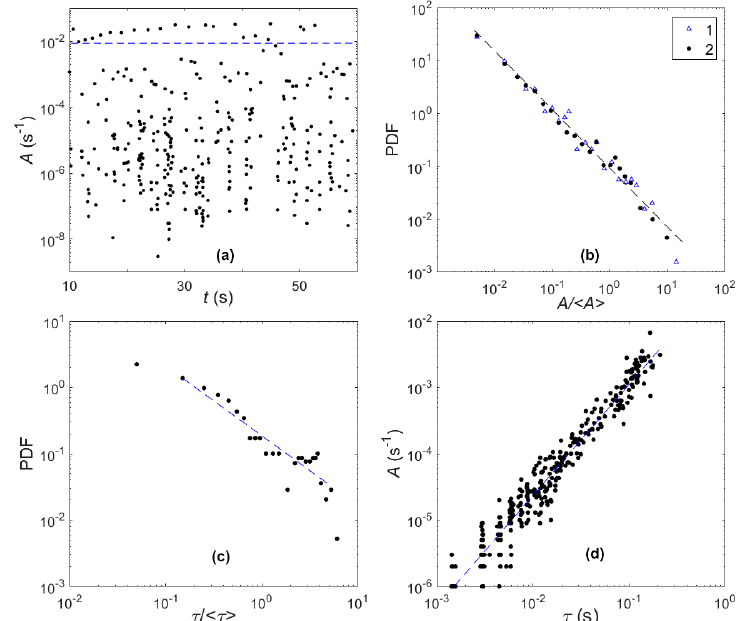
Figure 3. Processing of the local strain-rate responses. ( a ) Scatter of amplitudes of local strain-rate fluctuations, A , gathered by a local extensometer in the middle part of a specimen. The time interval corresponds to jerky flow ( ε ≥ ε cr ). ( b ) Examples of PDF for two separate extensometers. Similar to Figure 2, a dashed line is traced as a guide for the eye. The least-square evaluation renders the following mean and standard deviation for the estimates of the power-law exponent: 1—1.09 ± 0.04; 2—1.11 ± 0.04. ( c ) PDF of durations τ of serrations recorded by the extensometer 1 of Figure 3b. The respective slope α = 1.05 ± 0.11. ( d ) Amplitude–duration relationship for the same extensometer. The slope calculated for the conditional averages h = 1.65 ± 0.04.